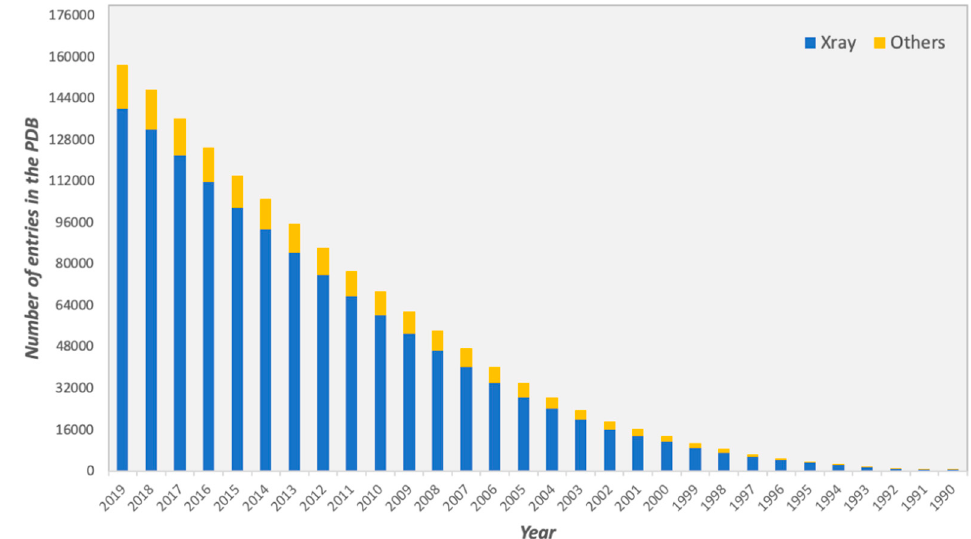
Figure 1. Total number of structures in the Protein Data Bank (PDB) from 1990 to October 2019. Structures determined by X-ray crystallography are depicted in blue, while structures determined by all other experimental techniques, such as Nuclear magnetic resonance (NMR) and Electron Microscopy or a combination of different methods, are shown in yellow.